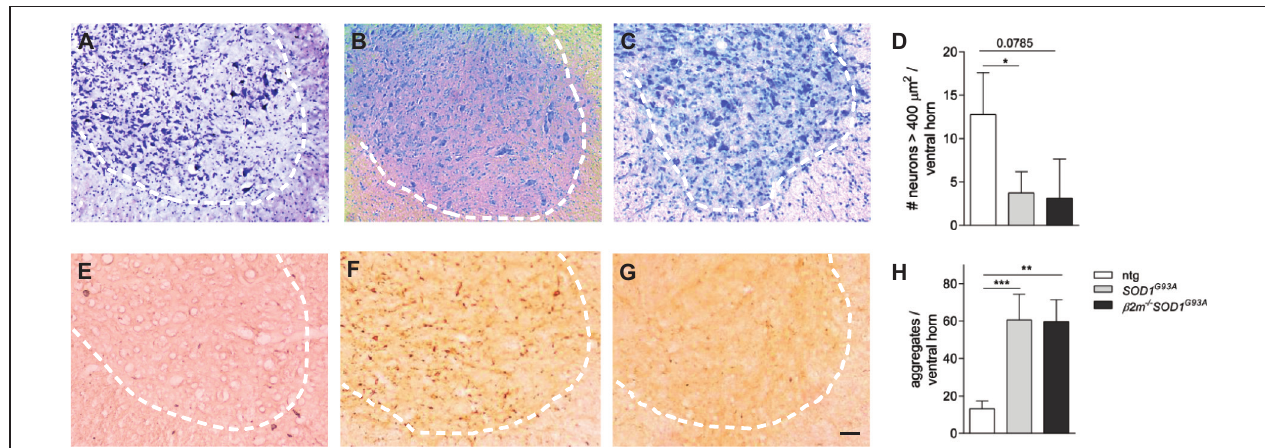
of > 250 µ m 2 neurons and > 400 µ m 2 motor neurons per ventral horn are quantified in (D) Ubiquitin immunoreactivity in spinal cord sections of non-transgenic, SOD1 G 93 A and β 2 m − / − SOD1 G 93 A mice are quantified in (H) Dashed lines delineate the ventral horn. Scale bar = 100 µ m. * p < 0.05, ** p < 0.01, *** p <